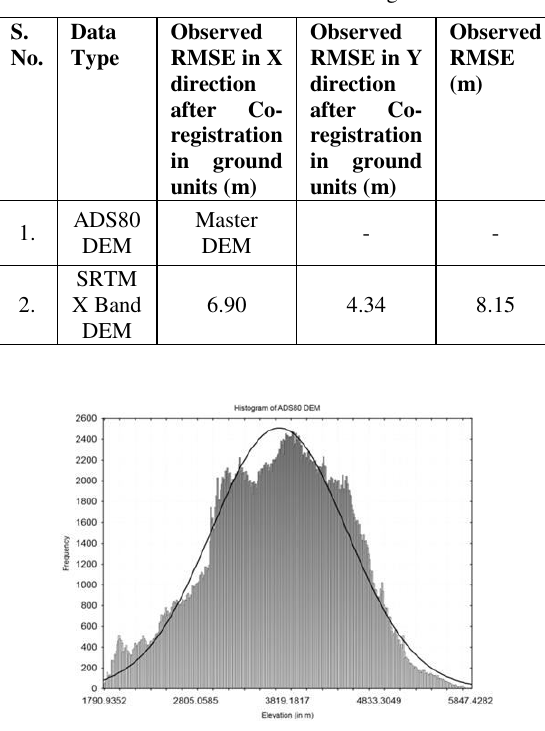
Figure 4: Histogram of ADS80 DEM